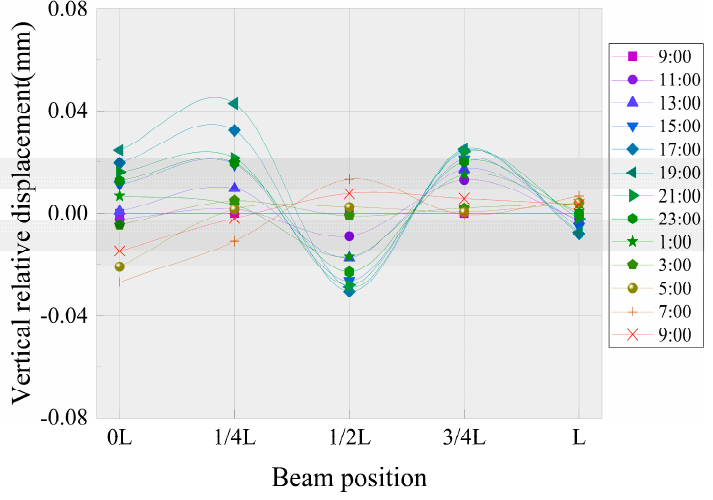
Figure 10. The displacement between the track slab and CA mortar layer.